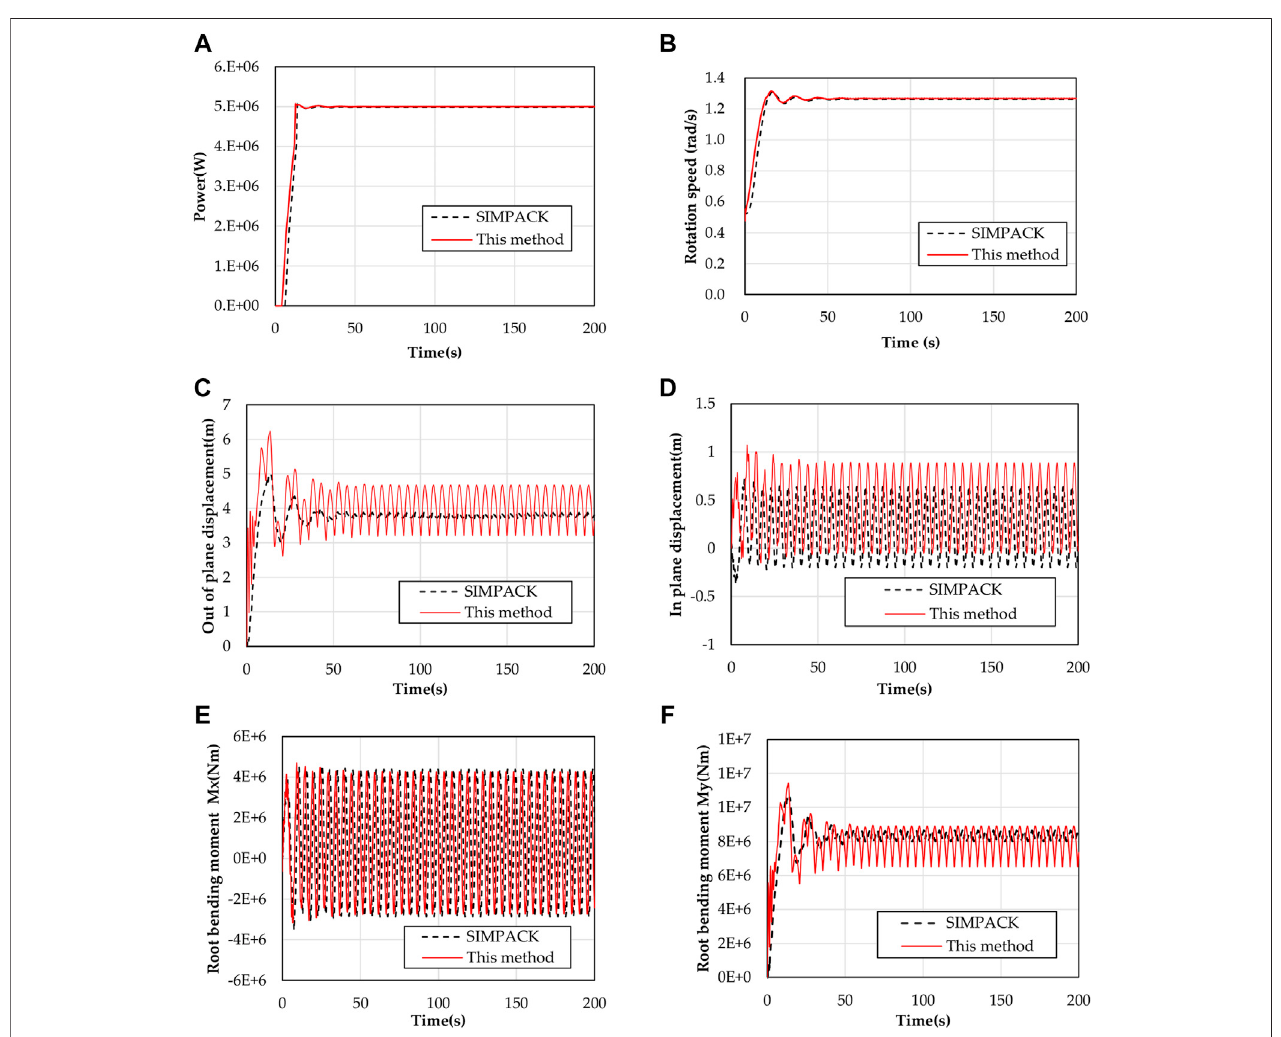
FIGURE 2 | Comparison of aeroelastic response results of blades under steady wind condition.